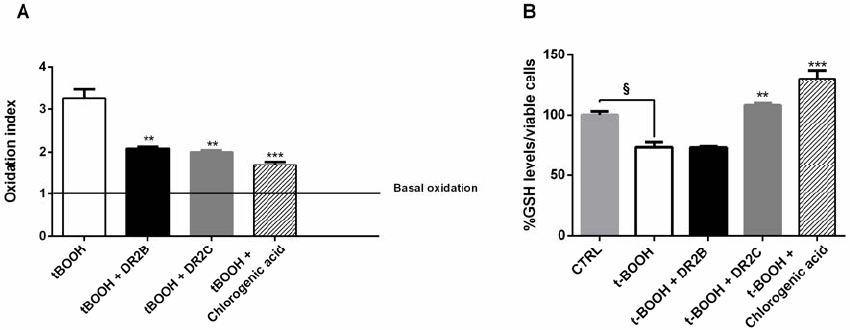
Figure 3. Effect of DR2B (100 μ g/mL), DR2C (100 μ g/mL), and chlorogenic acid (50 μ g/mL) on the ROS and GSH levels induced by tert ‐ butyl hydroperoxide (tBOOH; 5 μ M) in Caco2 cells under normoxia. ( A ) Reactive oxygen species (ROS) levels expressed as oxidation index with respect to the basal levels. ( B ) GSH levels measured in cell lysates were normalized to viable cells and expressed as a percentage (level from control cells was considered 100%). Data are mean ± SE from at least two independent biological replicates ( n = 2). § p < 0.01 vs. control; *** p < 0.001 and ** p < 0.01 vs. tBOOH by ANOVA followed by Dunnett’s multiple comparison post ‐ test.